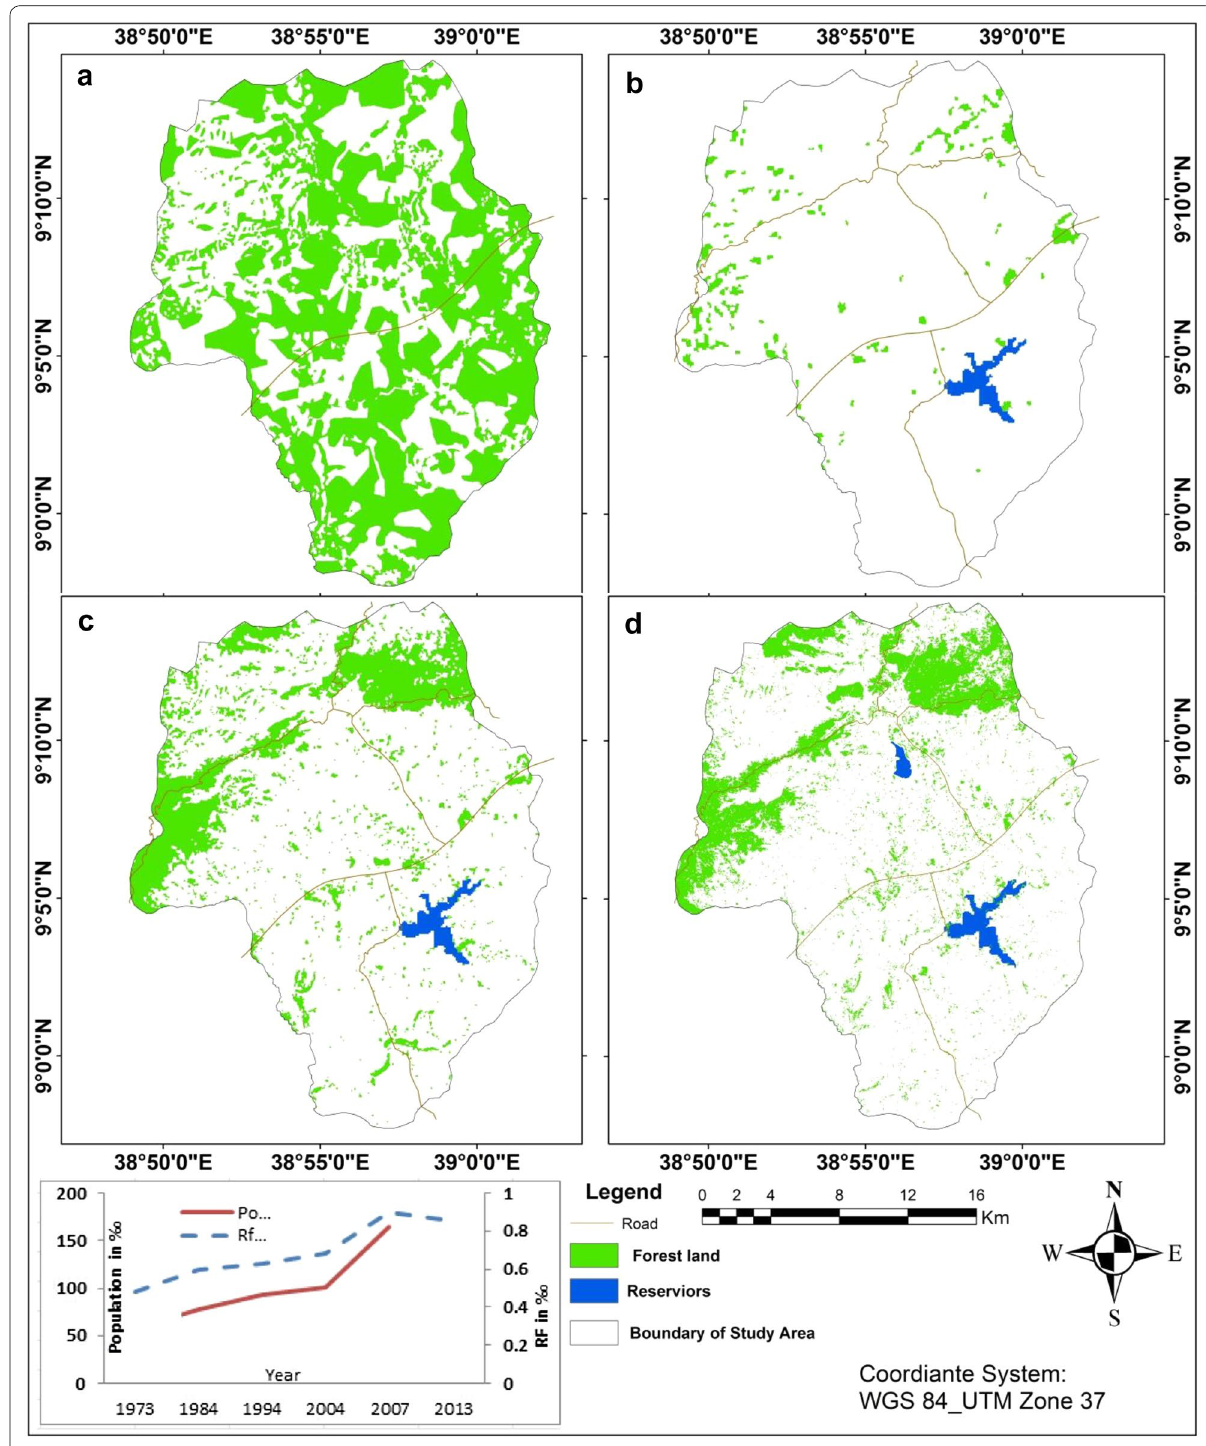
Fig. 6 Forest cover dynamics in 1957 ( a ), 1975 ( b ), 1995 ( c ) and 2017 ( d